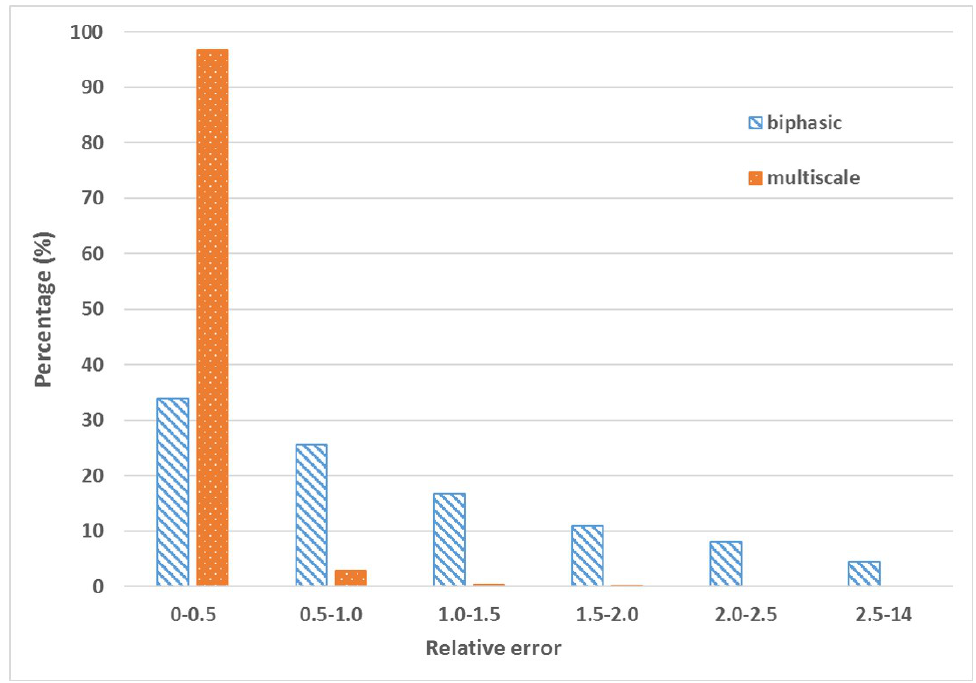
Figure 5. Distribution of relative errors obtained for predicting time-to-cure using machine learning with the biphasic and multiscale models. Measurements of all time points (0, 2, 7, 14 and 28 days) were used for the machine